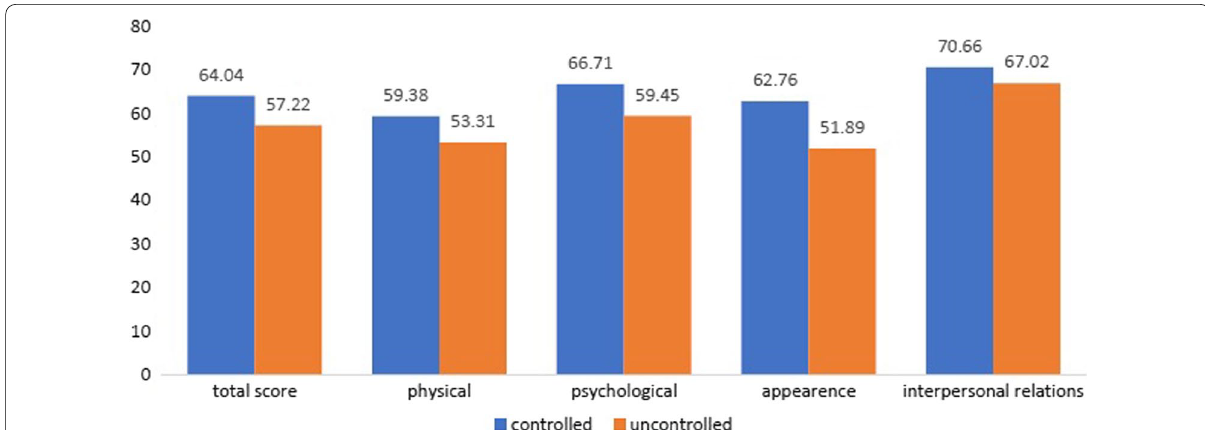
Fig. 1 AcroQol mean scores in biochemically controlled vs biochemically uncontrolled